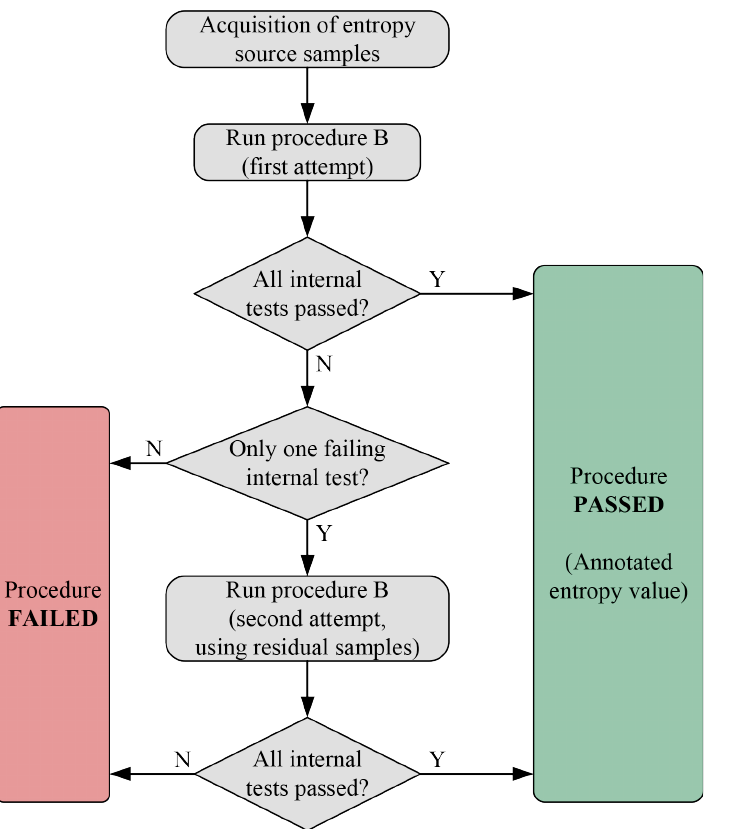
Figure 2. Flow diagram for entropy assessment when using the BSI suite (procedure